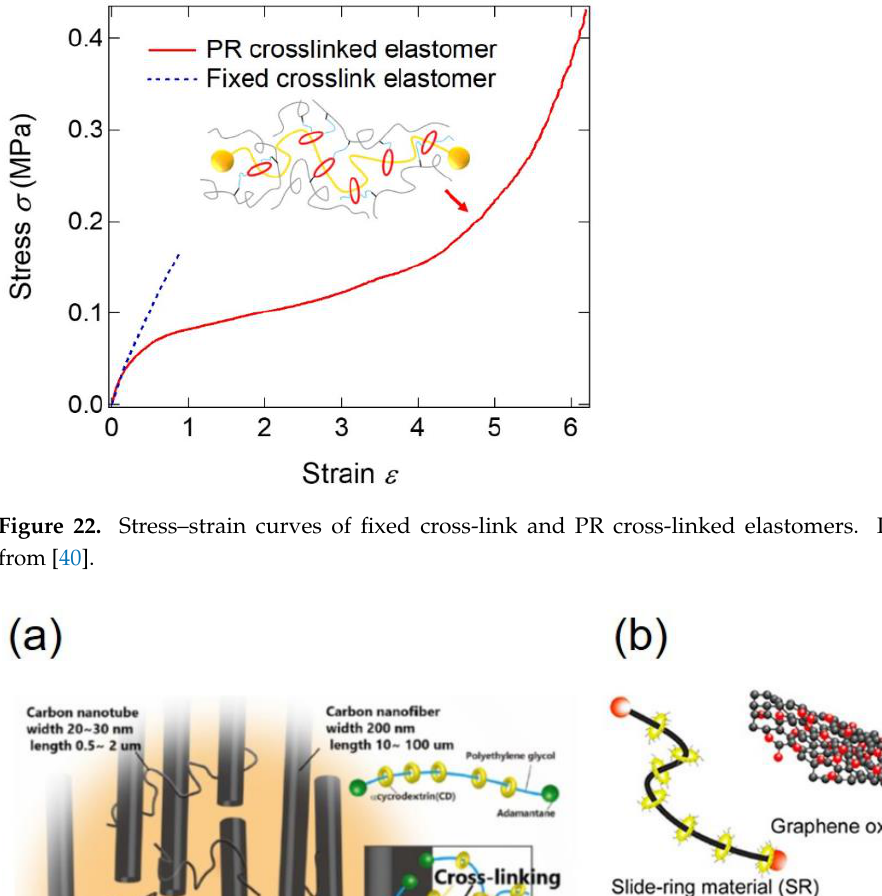
Figure 22. Stress – strain curves of fixed cross-link and PR cross-linked elastomers. Reprinted from [40].